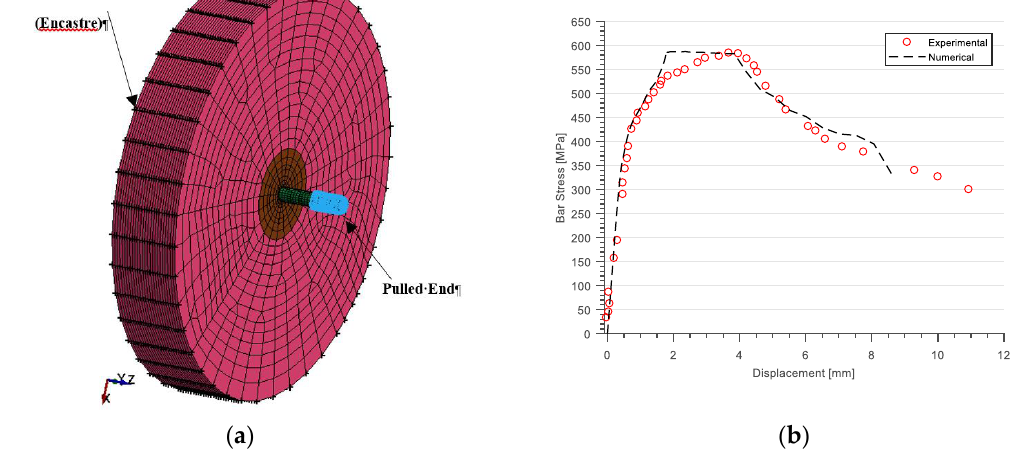
Figure 11. FE analysis of anchorage tests by Steuck et al. [2]: ( a ) model showing boundary conditions and pulled end; ( b ) bar stress vs. loaded-end slip at 7.68 d b (recreated using data from Steuck et al. [2]).